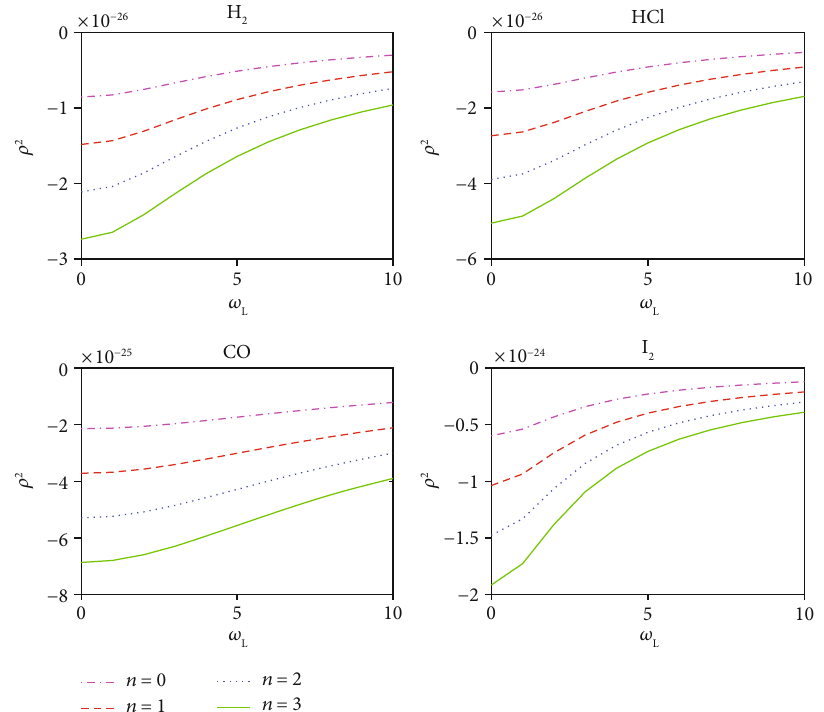
for the molecules (H , HCl, CO, L 2